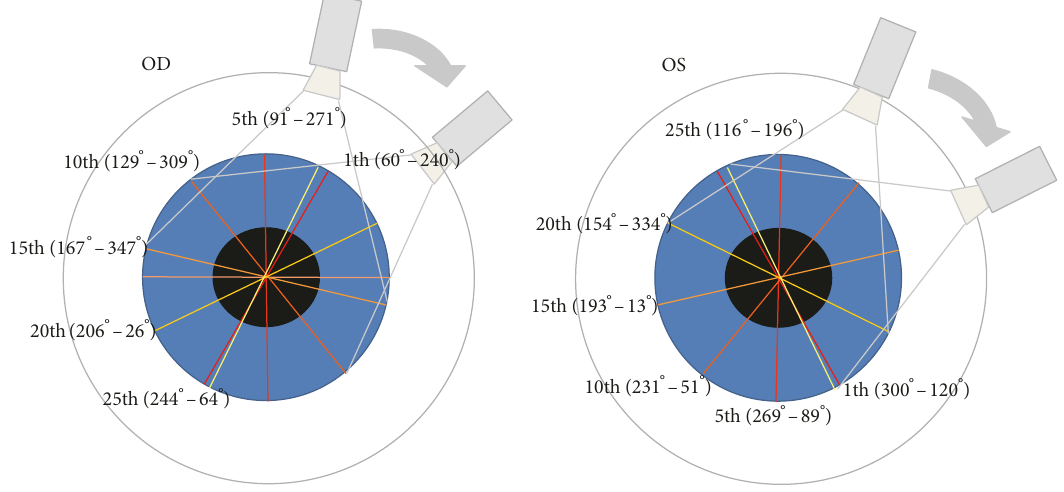
Figure 2: Basic settings of six selected segments in Pentacam.